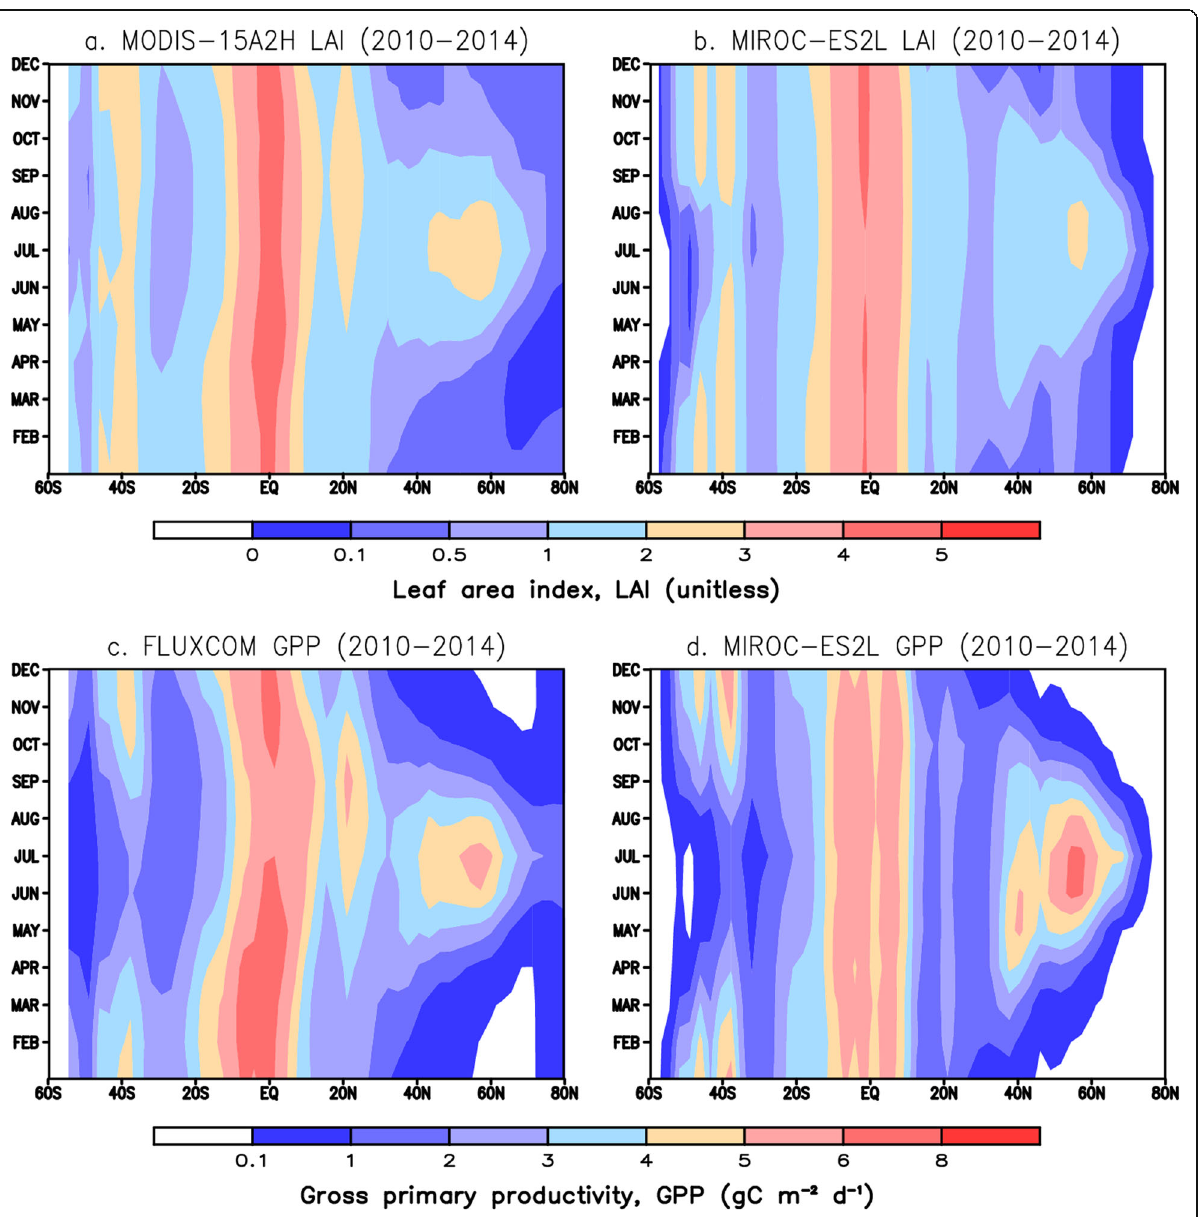
Fig. 8 Comparisons of MODIS satellite – derived LAI with that simulated by MIROC-ES2L ( a , b ; top row), and flux tower – based FLUXCOM GPP with MIROC-ES2L simulated GPP ( c , d ; bottom